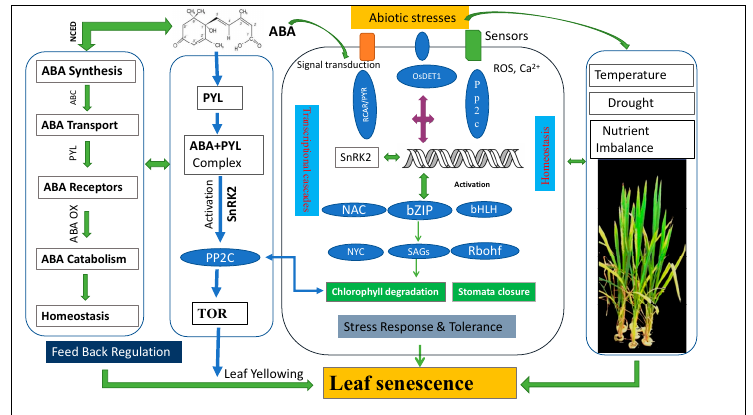
Figure 3. Systematic illustration of ABA-induced leaf senescence in response to abiotic stresses. DET1 : DE-ETIOLATED1 , ABC: ATP-binding cassette, TOR: target of rapamycin, bHLH: basic helix-loop-helix TF, Rbohf: respiratory burst oxidative homolog